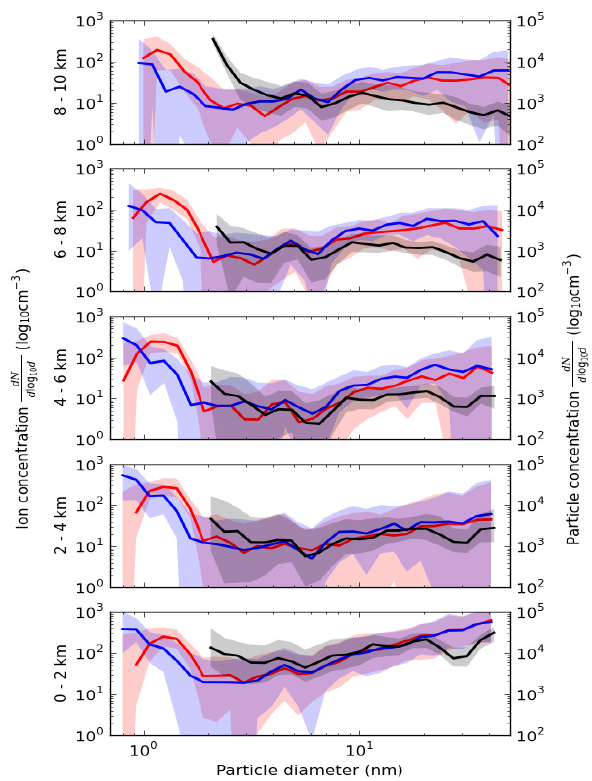
Fig. 6. Average particle (black) and ion (positive: red; negative: Figure 6: Average particle (black) and ion (positive: red; negative: blue) number size blue) number size distributions at different height levels during the distributions at different height levels during the EUCAARI LONGREX 2008 campaign. EUCAARI LONGREX 2008 campaign. The shaded area represents The shaded area represents variability (5 to 95 percentiles) of the corresponding number variability (5 to 95 percentiles) of the corresponding number size size distributions.